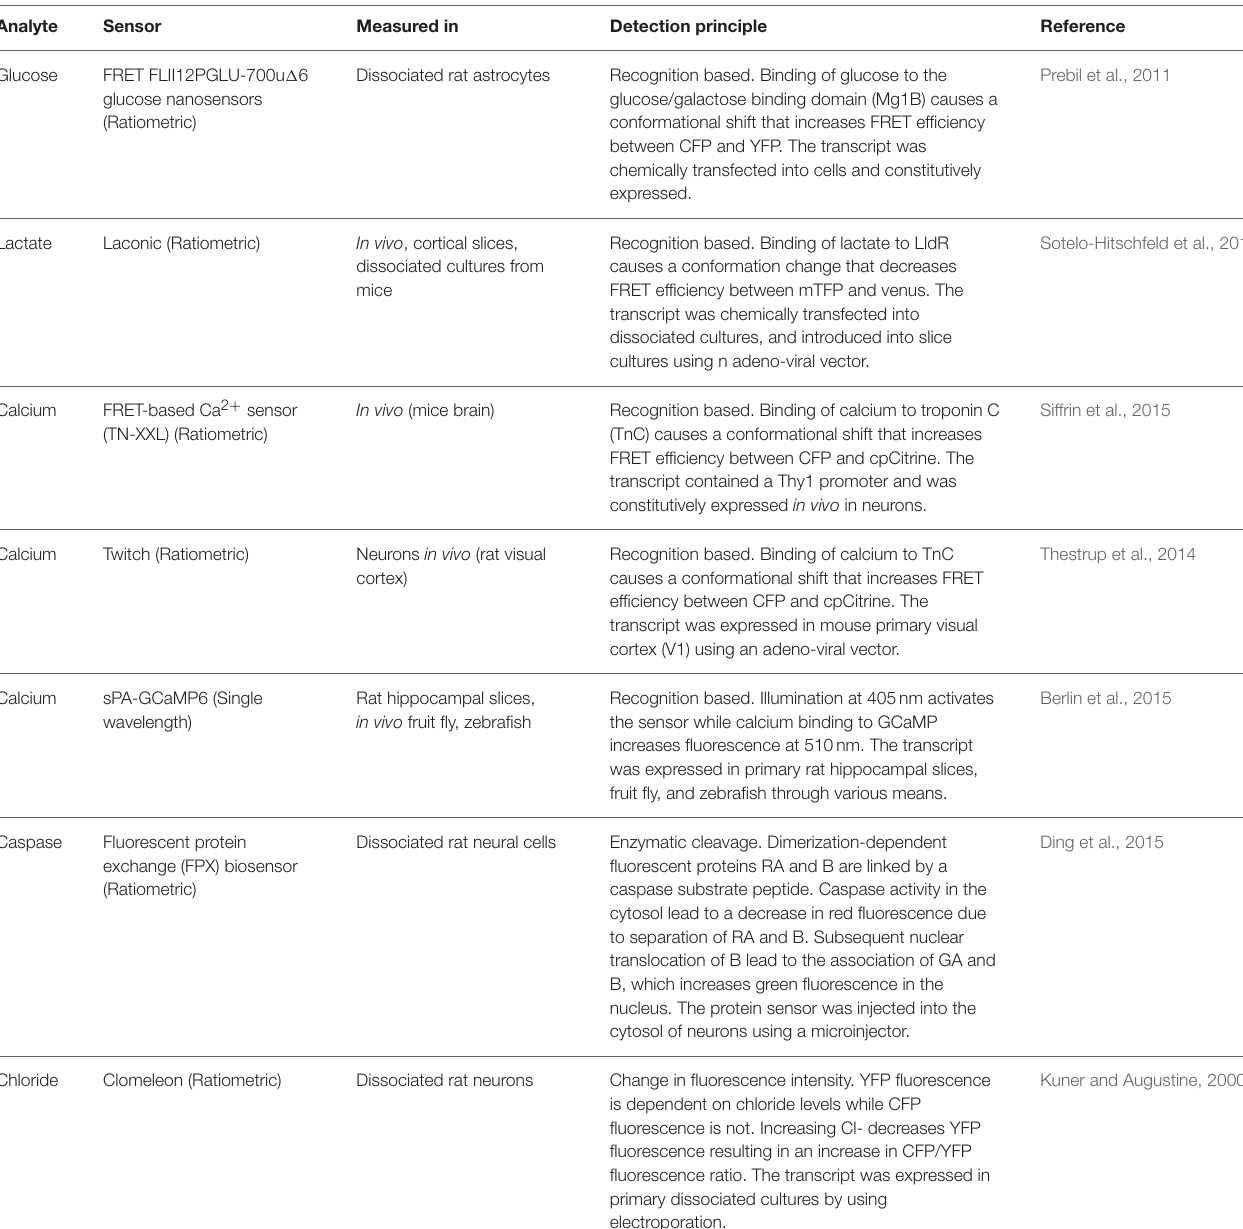
TABLE 3 | Examples of genetically engineered biosensors for the detection of ions and enzymes in neural cells.